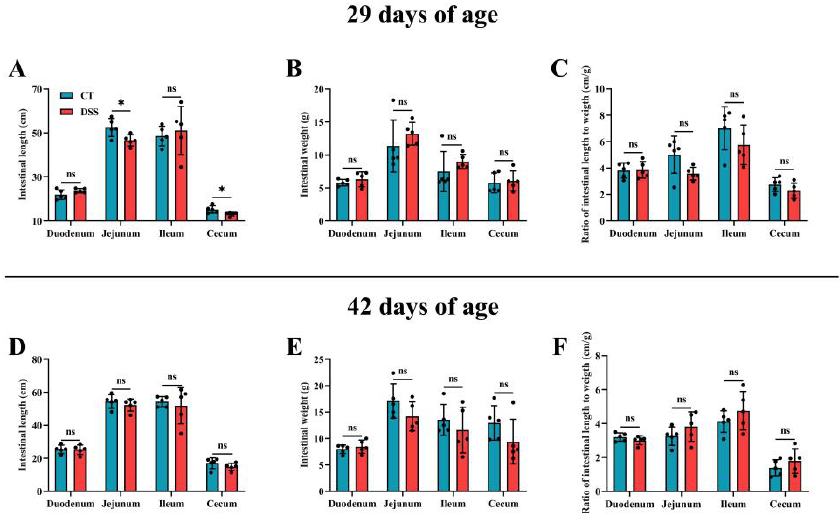
Figure 5. Effects of oral gavage of DSS on the intestinal development in broilers: ( A ) intestinal length at 29 days of age (n = 5 per group); ( B ) intestinal weight at 29 days of age (n = 5 per group); ( C ) ratio of intestinal length to weight at 29 days of age (n = 5 per group); ( D ) intestinal length at 42 days of age (n = 5 per group); and ( E ) intestinal weight at 42 days of age (n = 5 per group), ( F ) ratio of intestinal length to weight at 42 days of age (n = 5 per group). Values are means ± SD. * p < 0.05; ns: not significant ( p >